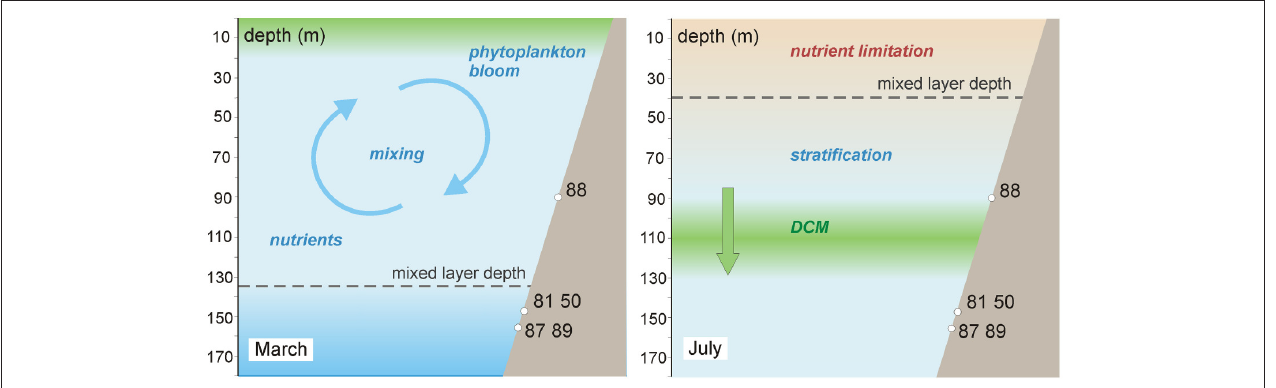
FIGURE 7 | Schematic model of seasonal changes in environmental conditions in the G. vangentsumi shells’ habitat (Madeira, Desertas Island). In early spring phytoplankton blooms are connected to high nutrient concentrations in surface waters, enhanced by ocean mixing driven by lower SST (March). Phytoplankton descend to find nutrient-rich waters as the surface becomes depleted as mixing becomes less intense. The formation of the deep chlorophyll maximum just above the shells’ habitat seems favorable in terms of long-term food availability. Sea surface temperatures and mixed layer depths are based on Mason et al. (2011) while the assumed depth of deep chlorophyll maximum is based on Fründt et al.